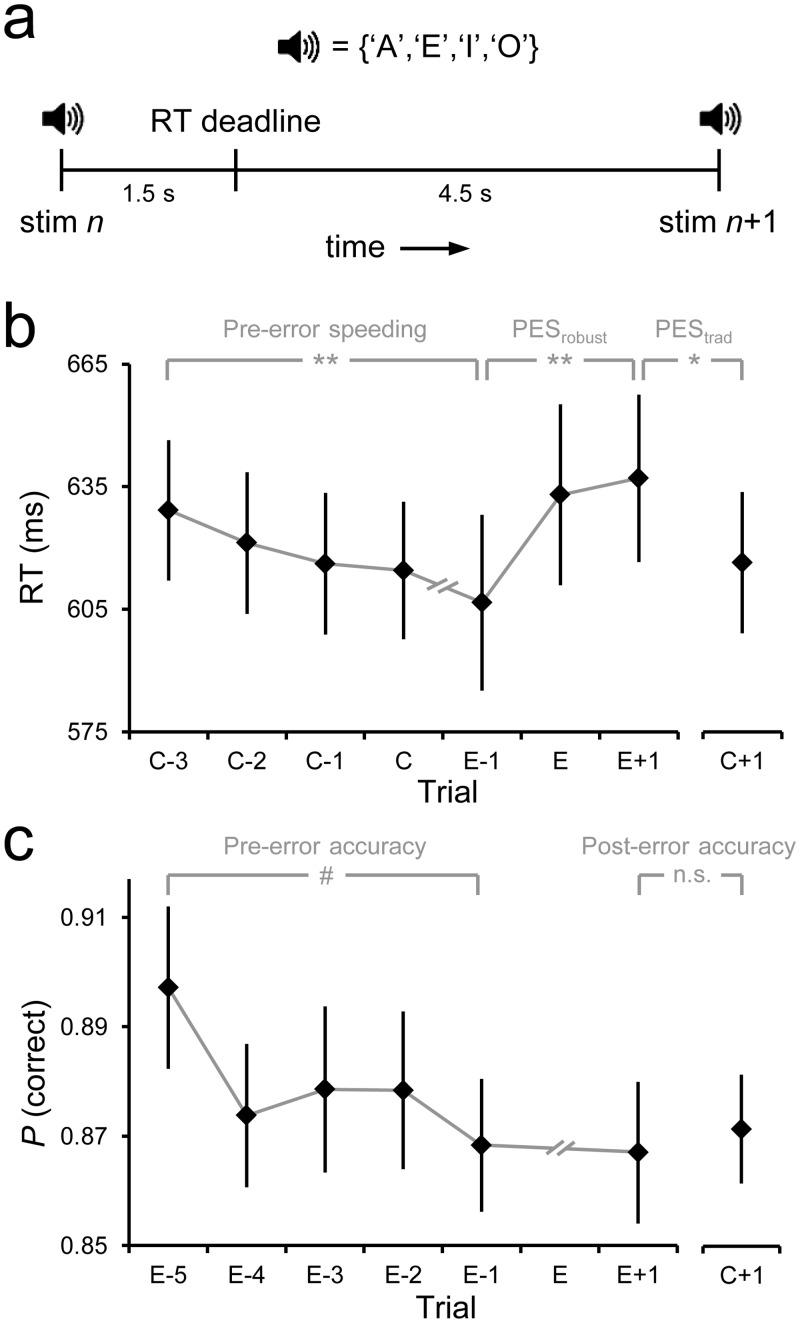
Task and behavioral results.(A) Timing of a trial of the auditory four-choice RT task. (B) Peri-error RTs, illustrating both pre-error speeding and PES. The latter was quantified using both ‘traditional’ and ‘robust’ methods (see Materials and Methods). (C) Peri-error response accuracy. Pre-error effects in b and c are linear contrasts across consecutive trials. Error bars indicate s.e.m. **p<0.01, *p<0.05, #p<0.1.